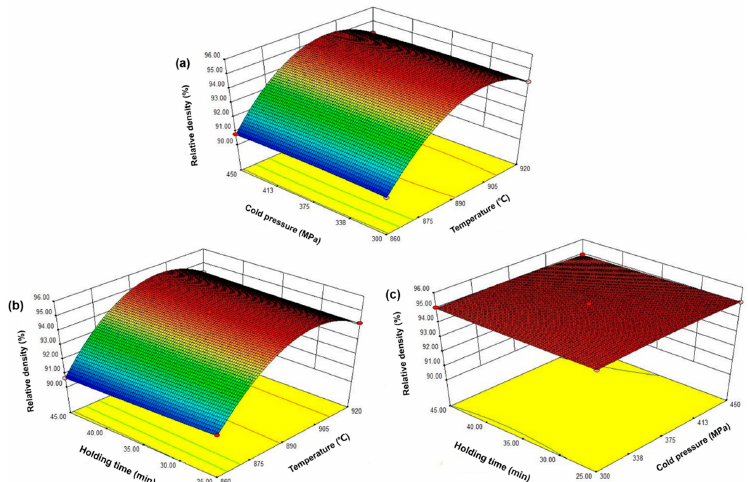
Figure 5. Response surface graph: the effect of sintering temperature, holding time, and cold pressure on the relative density of the sintered sample, ( a ) sintering temperature and holding time; ( b ) sintering temperature and cold pressure; ( c ) holding time and cold pressure.